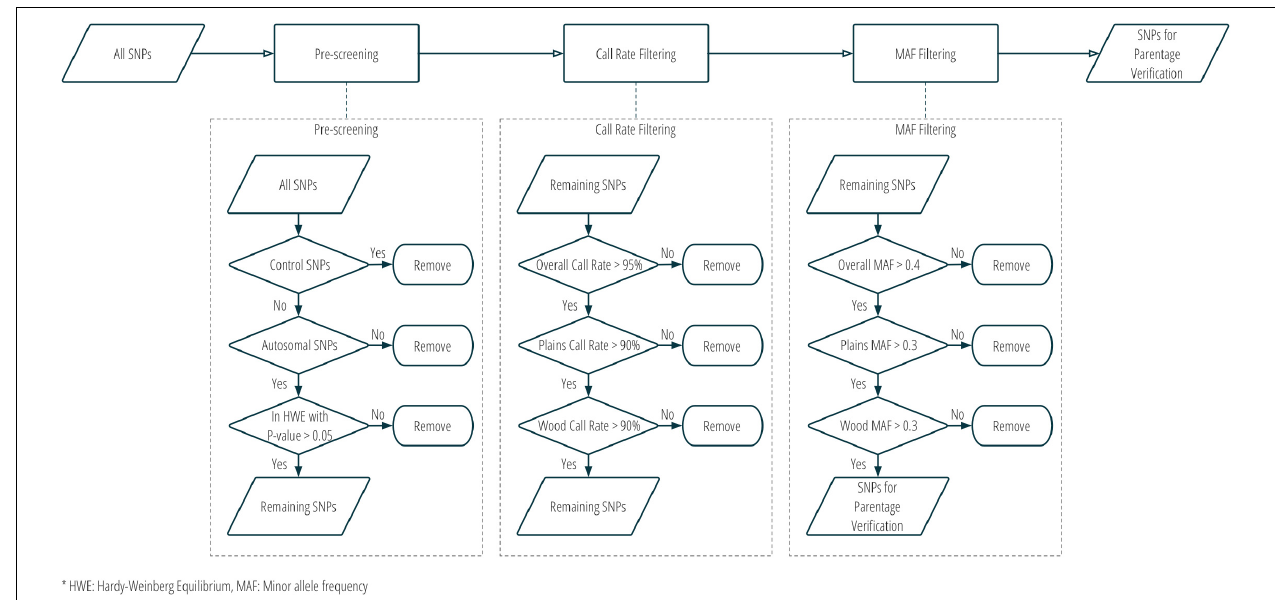
FIGURE 3 | Workflow of SNP selection for parentage verification, based on genotype data from the validation population.